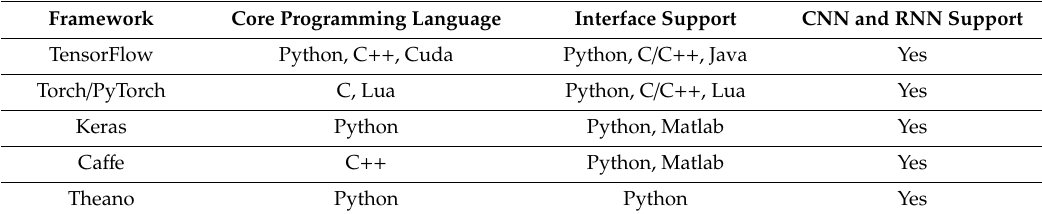
Table 4. Comparison of popular deep learning